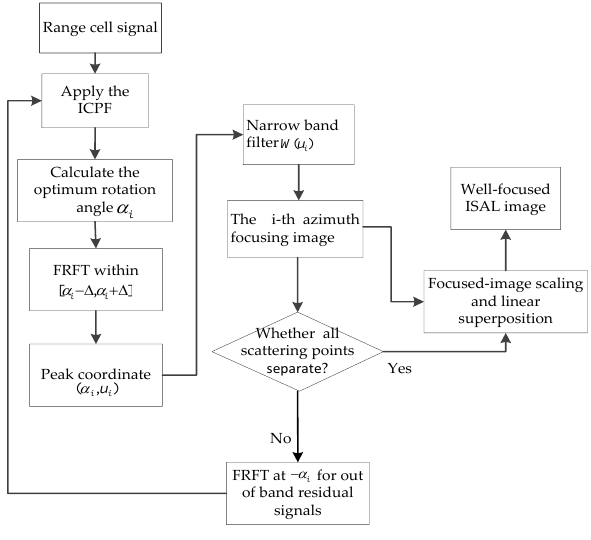
Figure 4. The imaging procedure for the azimuth